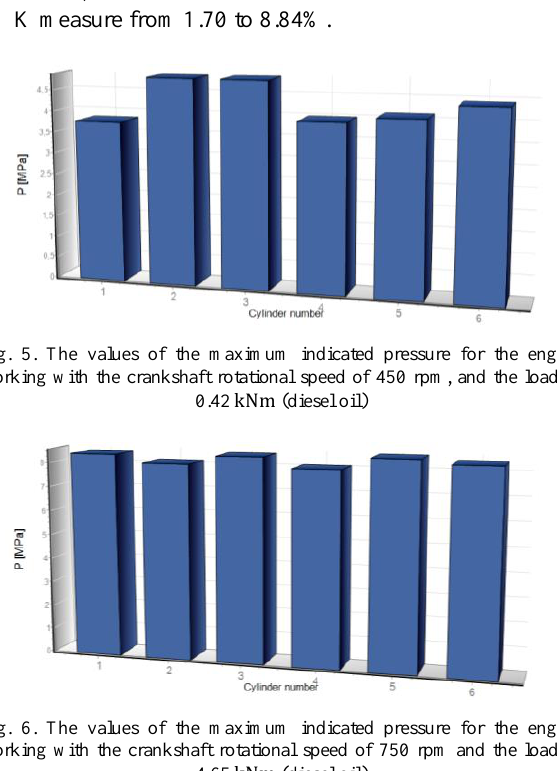
9.72%,  K measure from 1.70 to 8.84%.